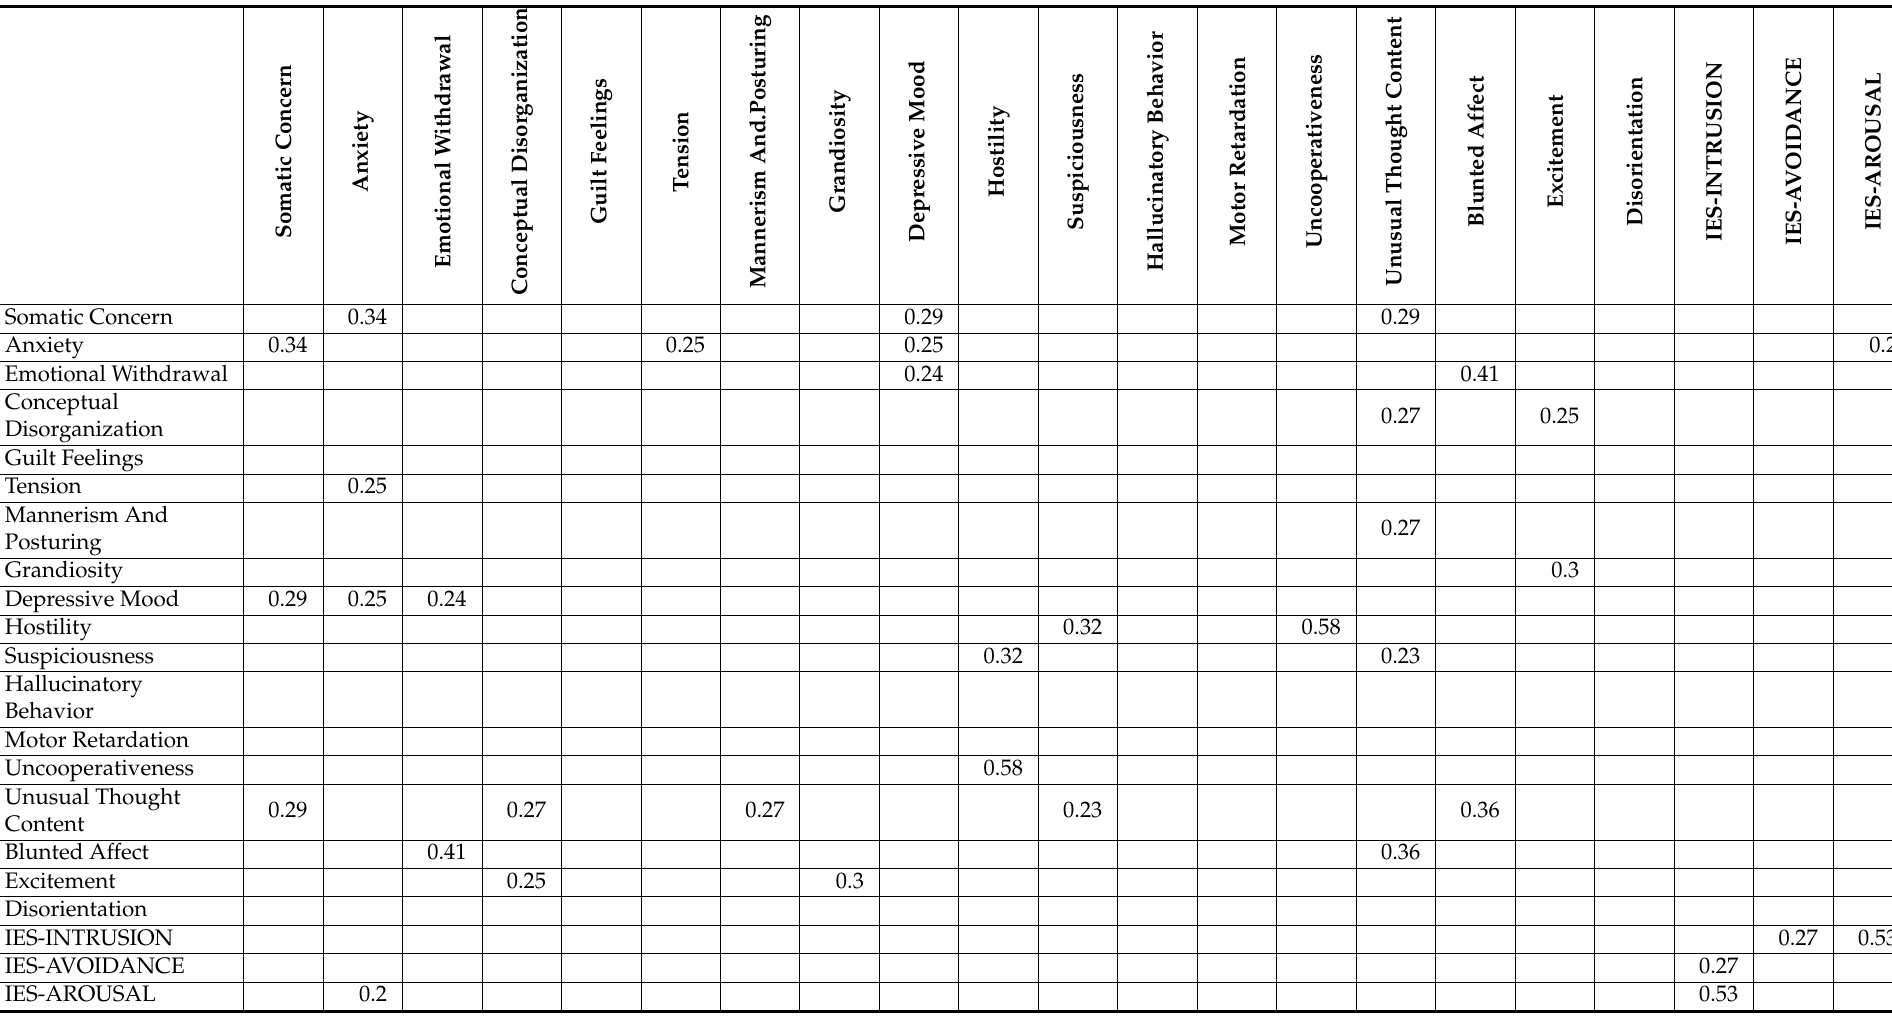
Table 3. Weighted adjacency matrix of the April